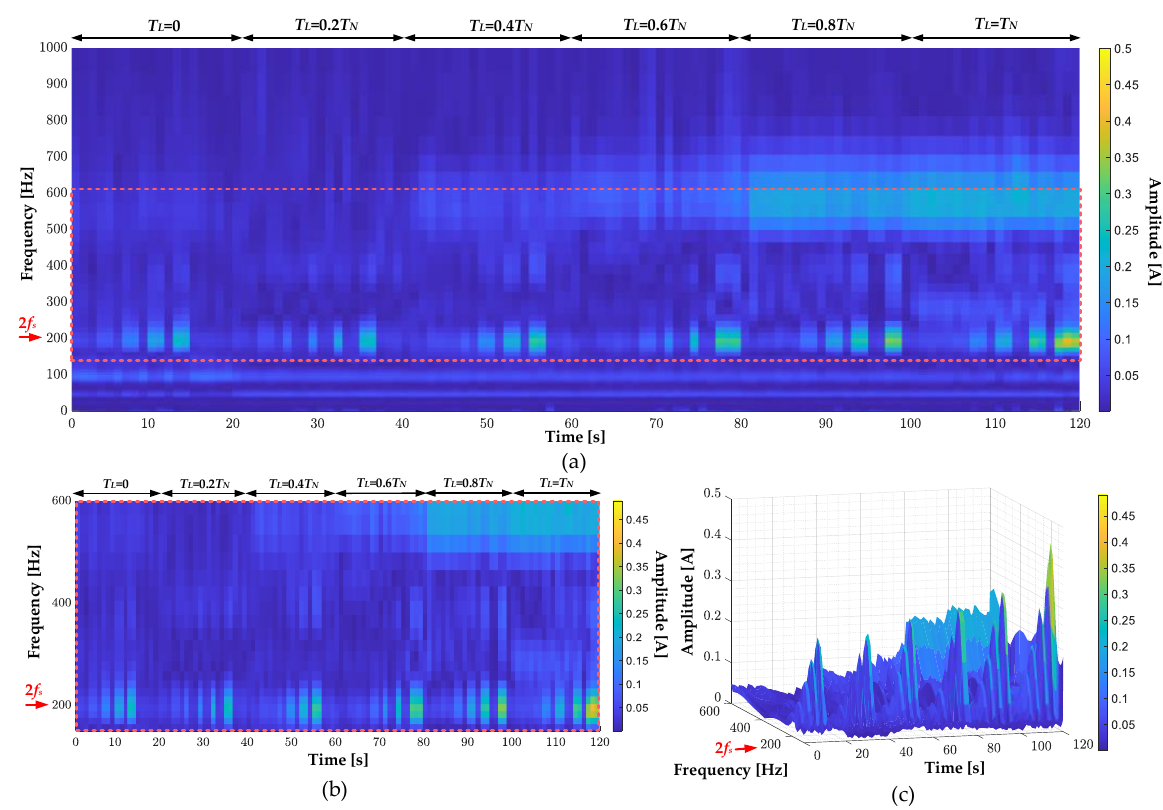
Figure 10. ( a ) CWT scalogram of the stator phase current space vector module waveform; ( b ) 2D and ( c ) 3D scalograms of the stator phase current envelope waveform for narrowed frequency and colormap range ( T L = var, f s = 100 Hz).